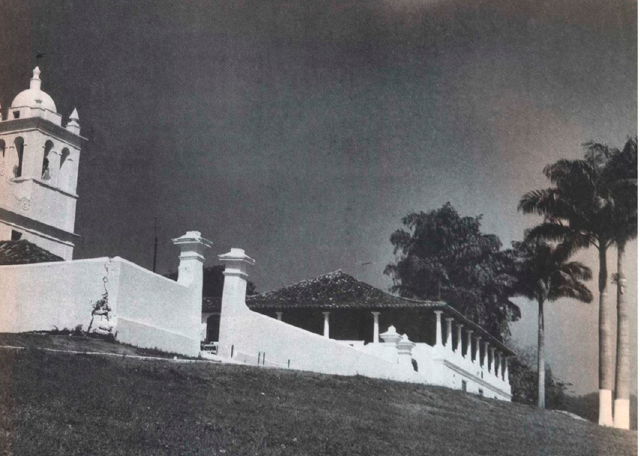
Figure 2. Colubandê Plantation House, photograph by Lúcio Costa, courtesy of archive IPHAN Rio de Janeiro.